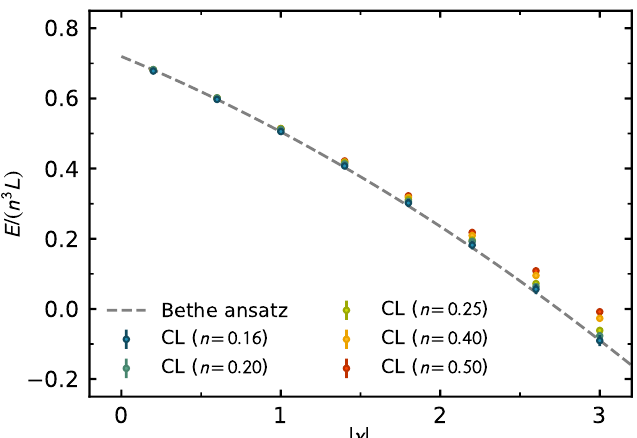
Figure 1: Ground-state energy for attractively interacting spin-up and spin-down fermions in units of n 3 L as a function of the modulus of the coupling strength γ as obtained from our CL study (symbols). Systems with fixed spin-polarization p = 0.5 for total densities of n = 0.16,0.2,0.25,0.4 and 0.5 are shown. For comparison, the exact BA result for the thermodynamic limit [ 67 ] is shown (gray dashed